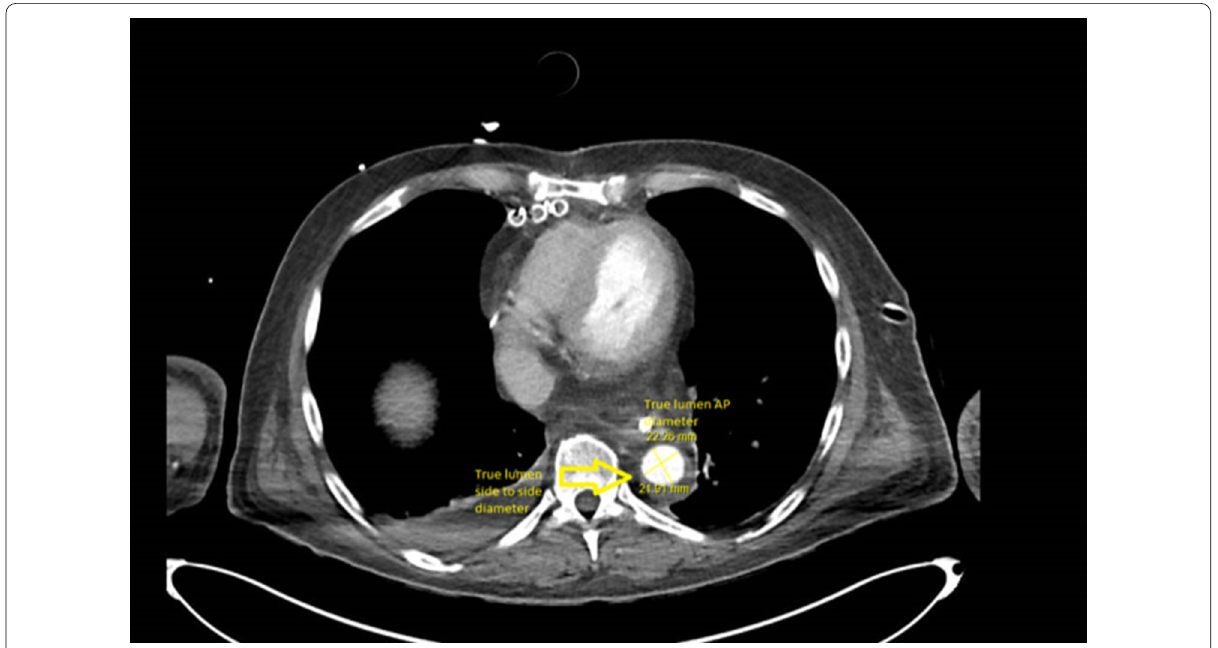
Fig. 1 Multislice computed tomography showing true lumen largest antero-posterior and side to side diameters measured at the level of the right diaphragmatic